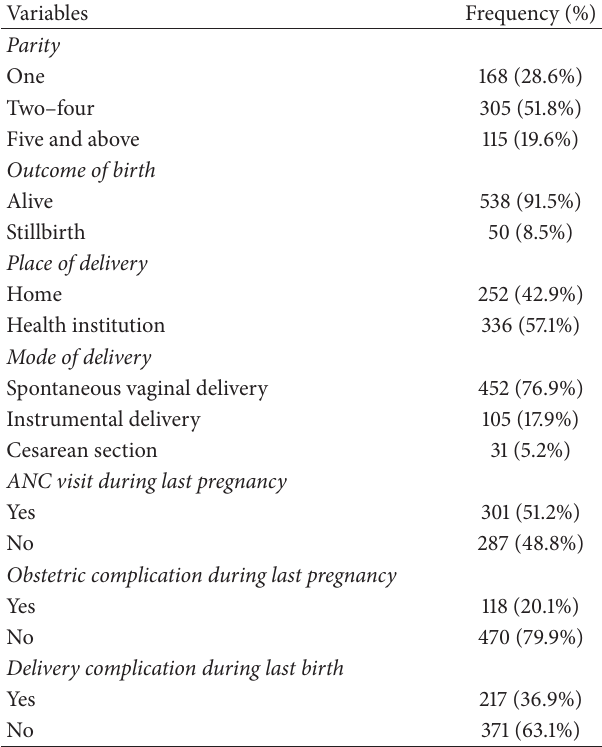
Table 2: Obstetric characteristics of respondents who gave birth in the last 12 months in Debremarkos town, northwest Ethiopia, December, 2014 ( 𝑛 = 588 ).